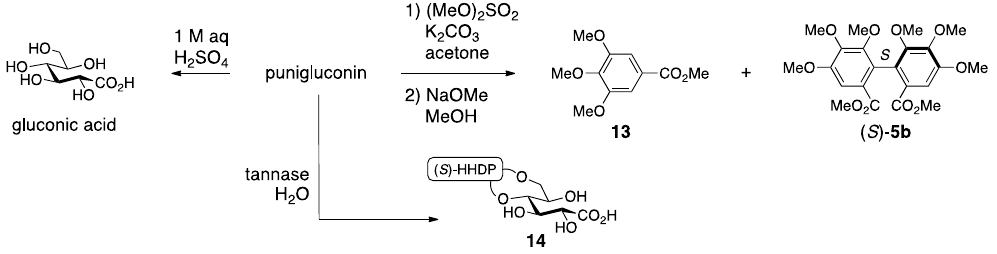
Figure 7. The transformations used in the determination for the first structure of punigluconin ( 11 ).